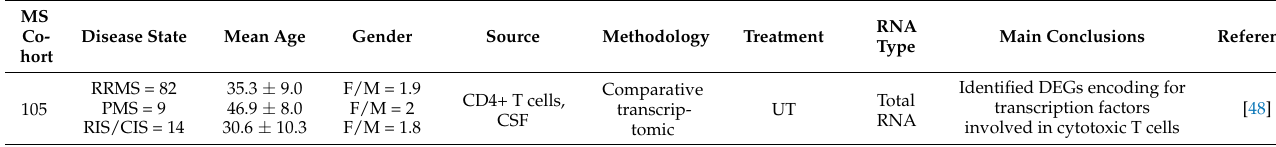
Table 5. Overview of the studies exploring transcriptomes in multiple